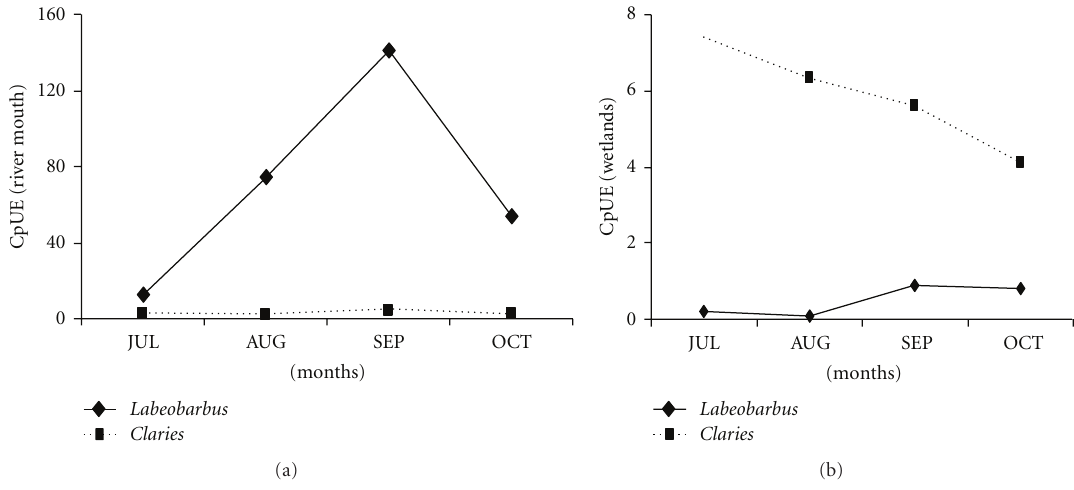
Figure 6: CpUE of Labeobarbus and Clarias at Ribb River mouth (a) and in Shesher and Welala Wetlands (b).